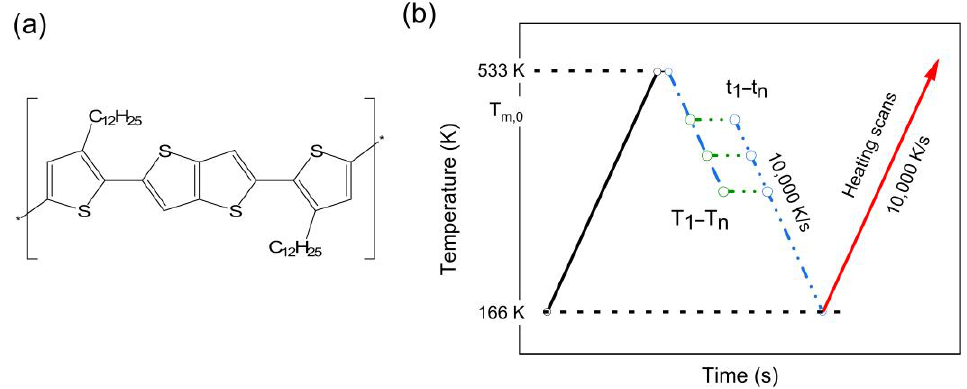
Figure 1. Different temperature annealing information of PBTTT conjugated polymer. ( a ) Chemical structures of PBTTT. ( b ) Temperature–time profile for generation and analysis of annealing peaks in FSC heating scans.